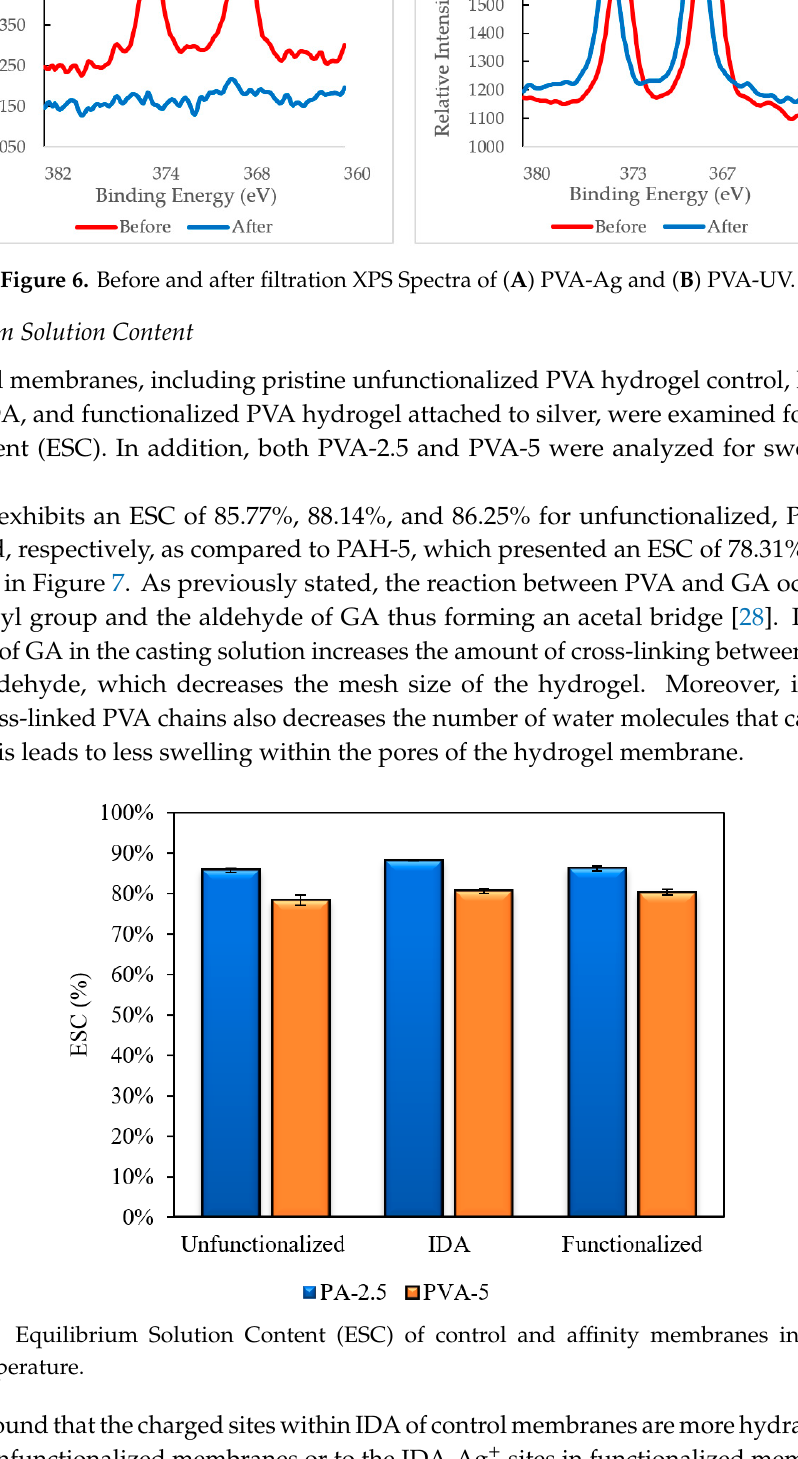
Figure 7. Equilibrium Solution Content (ESC) of control and affinity membranes in water at room temperature.